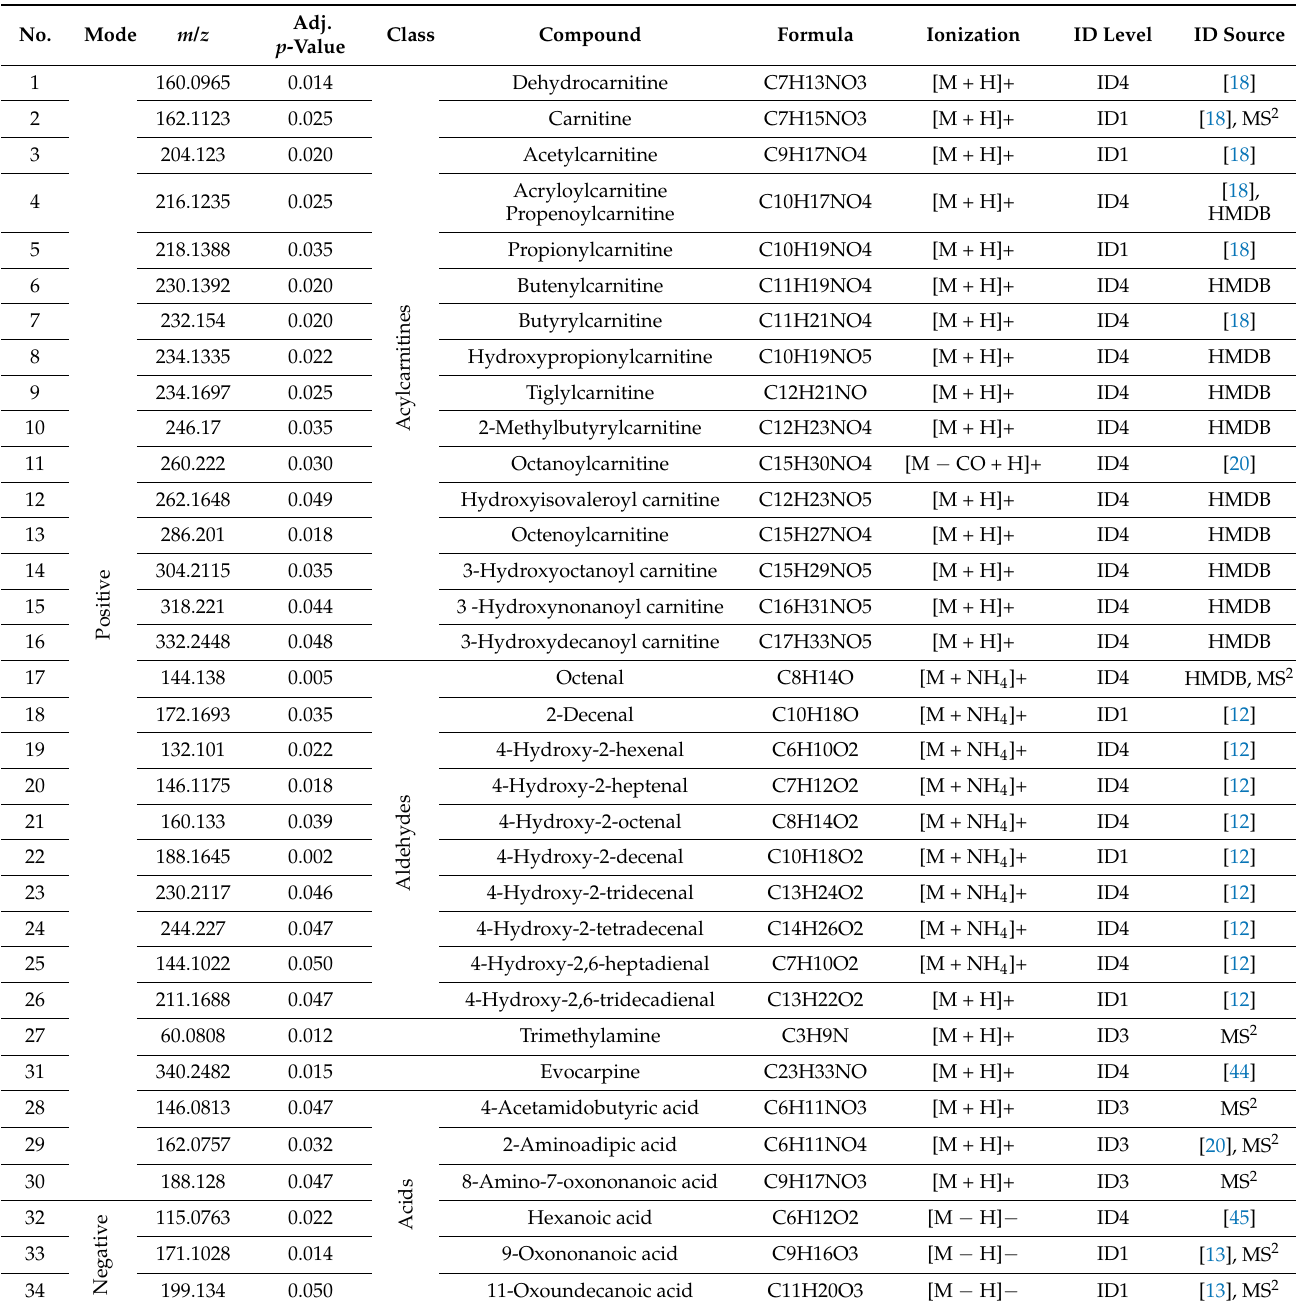
Table 1. Compounds that were putatively identified and elevated in the healthy control group. Adj. = adjusted, Lit. = literature, ID = identification. Reproduced with permission of the © ERS 2022